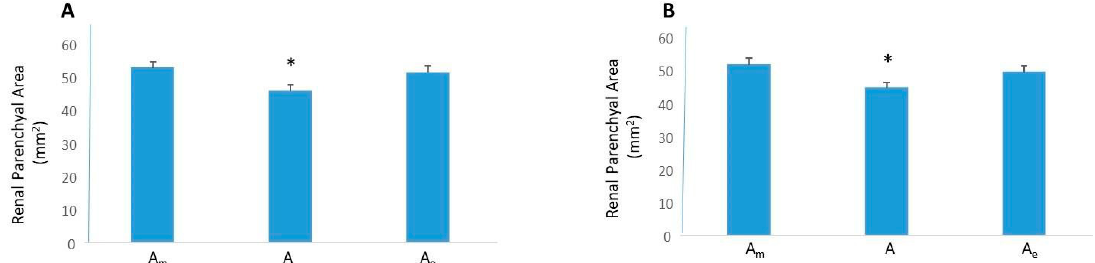
Figure 8. Renal parenchymal area in healthy and diseased mice (STZ + NaCl). Left and right kidneys were sourced from healthy adult male and female SV129 mice or adult male and female SV129 mice with diabetic nephropathy. ( A ) In coronal left kidney slices, Am is greater than A (*, p < 0.01) but not different from Ae . ( B ) In coronal right kidney slices, Am is greater than A (*, p < 0.01) but not different from Ae .